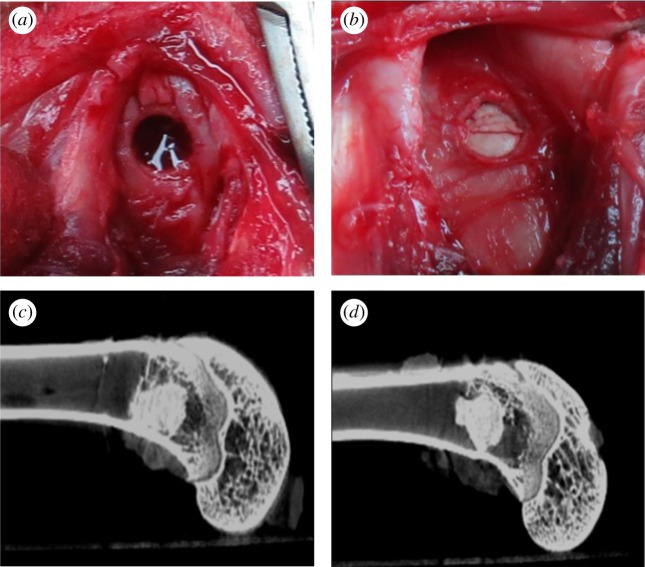
The image for PMMA composites implanted into bone tissue. (a) Appearance of the femoral condyle bone defect. The defect was implanted with injectable composites (b). Micro CT images of defect site were taken after three months' implantation with PMMAn20 (c) and PMMAg20 (d).